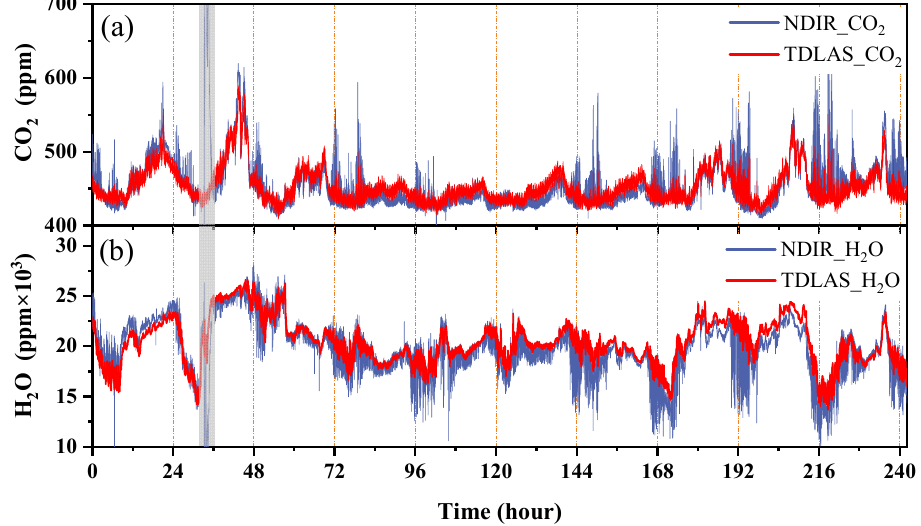
Figure 8. Comparison of ( a , b ) CO 2 and H 2 O concentrations, respectively, for approximately 10 days.